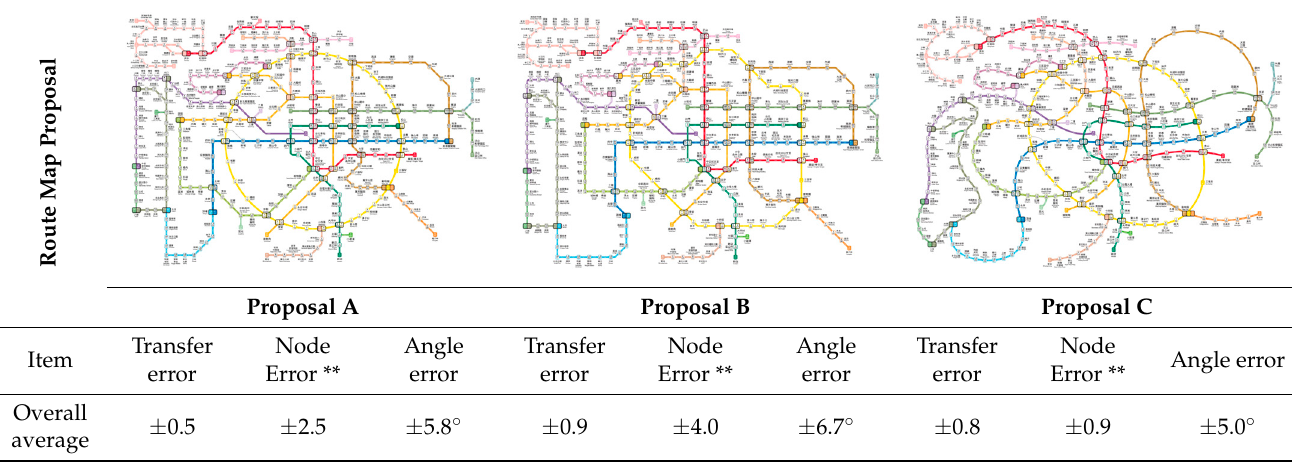
Table 9. Experiment 2 Route planning model and cognitive route map comparison.